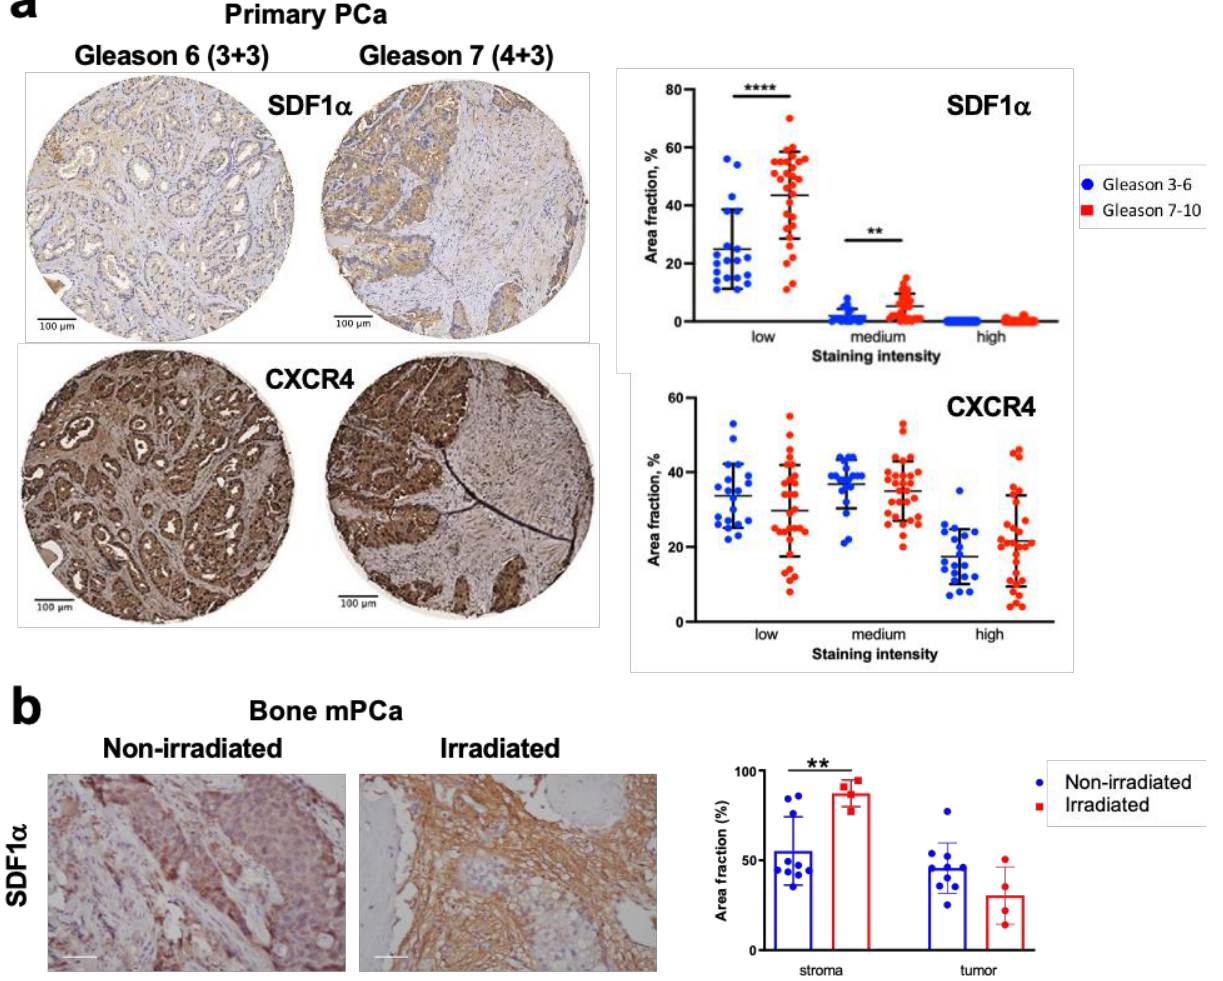
Figure 1. Expression of SDF1 α and CXCR4 in primary and bone metastatic prostate cancer (mPCa) tissues. ( a ) Representative images and quantitative analysis of SDF1 α and CXCR4 immunostaining in primary PCa tissue, stratified by Gleason score (Gleason 3 – 6: n = 20, median score 6, median age 76 ± 9 years vs. Gleason 7 – 10: n = 29, median score 8, median age 78 ± 6 years) and staining intensity (high/medium/low) analyzed with ImageJ software using predefined thresholds for the respective categories. ( b ) Representative images and quantification of SDF1 α expression by immunostaining in metastatic PCa tissue, radiation-naïve, or previously irradiated less than a month prior to surgery; scale bar: 50 µm. ** p < 0.01; **** p < 0.0001.